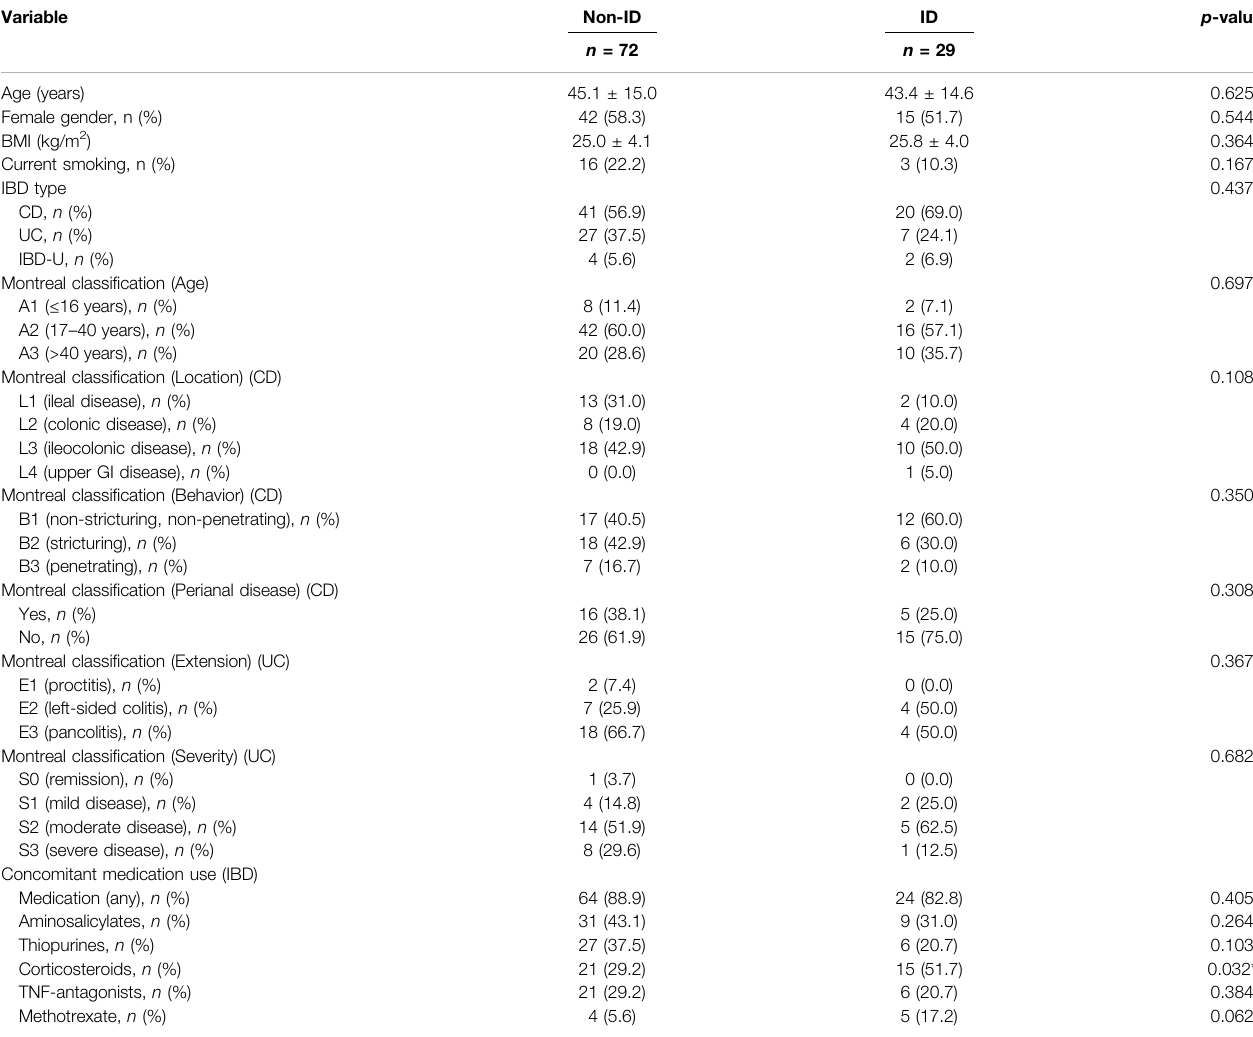
TABLE 1 | Descriptive statistics of IBD patients with differences shown between IBD patients with normal iron status (non-ID) and iron de fi ciency (ID).